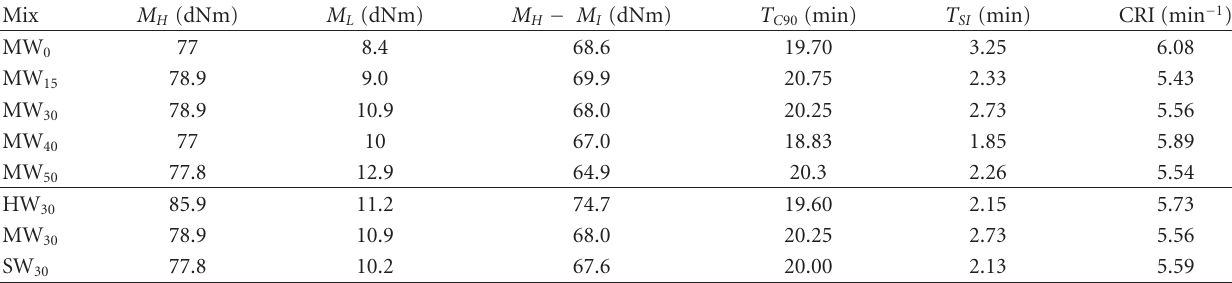
Table 3: Vulcanization characteristics of WHF-EPDM composites.